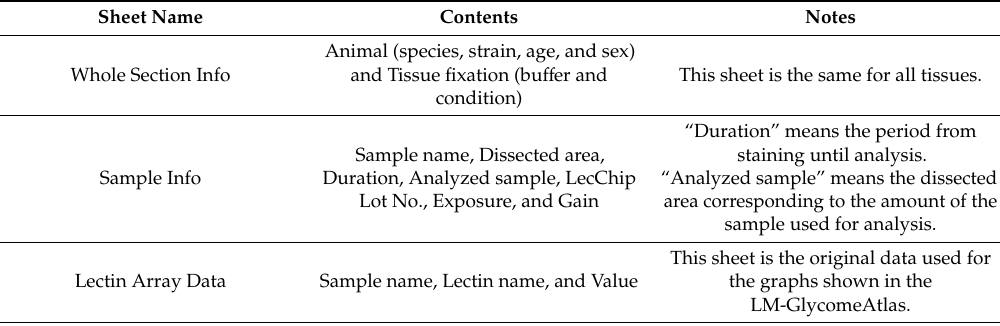
Table 2. Summary of the contents of the Excel data file.